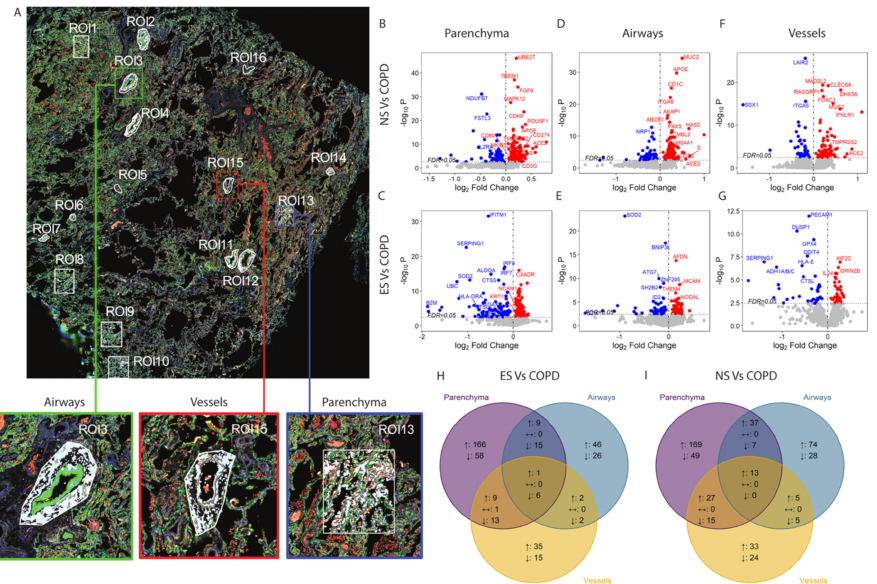
Figure 2. NanoString GeoMX spatial transcriptomic profiling: ( A ) Image of a lung tissue section from a COPD subject stained with pan-cytokeratin (green) to identify epithelial cells, CD45 (red) to identify lymphocytes, and SYTO13 (blue) to identify nuclei. Sixteen randomly selected regions of interest (ROIs) were sampled for spatial protein and RNA analysis and are highlighted in white. The higher-magnification inserts show representative airways (green), vessels (red), and parenchyma (blue) structures selected as ROIs. ( B – G ) Volcano plots showing the genes expressed in the lung parenchyma ( B , C ), airways ( D , E ), and vessels ( F , G ) of patients with COPD who died of COVID- 19 versus never-smoker controls (NS, panels B , D , F ) and ever-smoker controls (ES, panels C , E , G ). The data were assessed using generalized estimating equations (GEEs) accounting for multiple ROIs per case and were adjusted for age. The red dots indicate upregulated genes and the blue dots downregulated genes in COPD patients versus never- and ever-smokers for the specific tissue structures. The horizontal dotted line indicates the significance threshold of FDR < 0.05, and the vertical dashed line indicates the effect size of 0. The gray dots indicate genes that were not significant at FDR < 0.05. The top genes ranked by p -value are labeled with their gene symbols. ( H , I ) Venn diagram comparing the transcriptomic signatures in the parenchyma, airways, and vessels structures in COPD vs. ever-smoker controls ( H ) and vs. never-smoker controls ( I ). The up/down arrows indicate genes that are up/downregulated in the specific structure, and the double-sided arrows indicate markers with the inconsistent direction of change between tissue